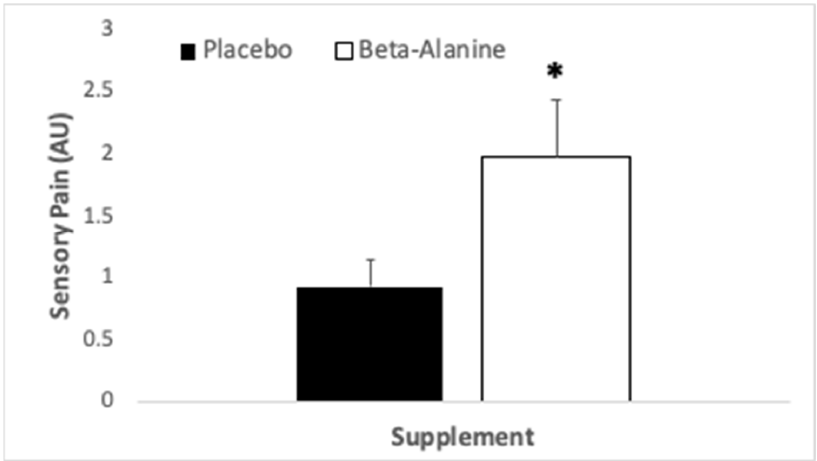
Figure 4. Sensory pain (arbitrary units), as perceived by participants ( N = 20) who consumed β -alanine prior to immersion in nature and a subsequent hike. * indicates significant difference between trials.